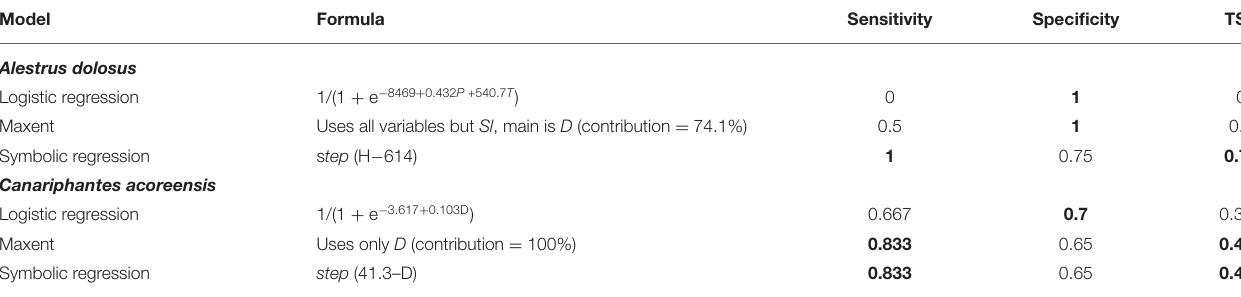
TABLE 2 | Species distribution models for two endemic arthropod species on the island of Terceira (Azores, Portugal). Model Formula Sensitivity Specificity TSS